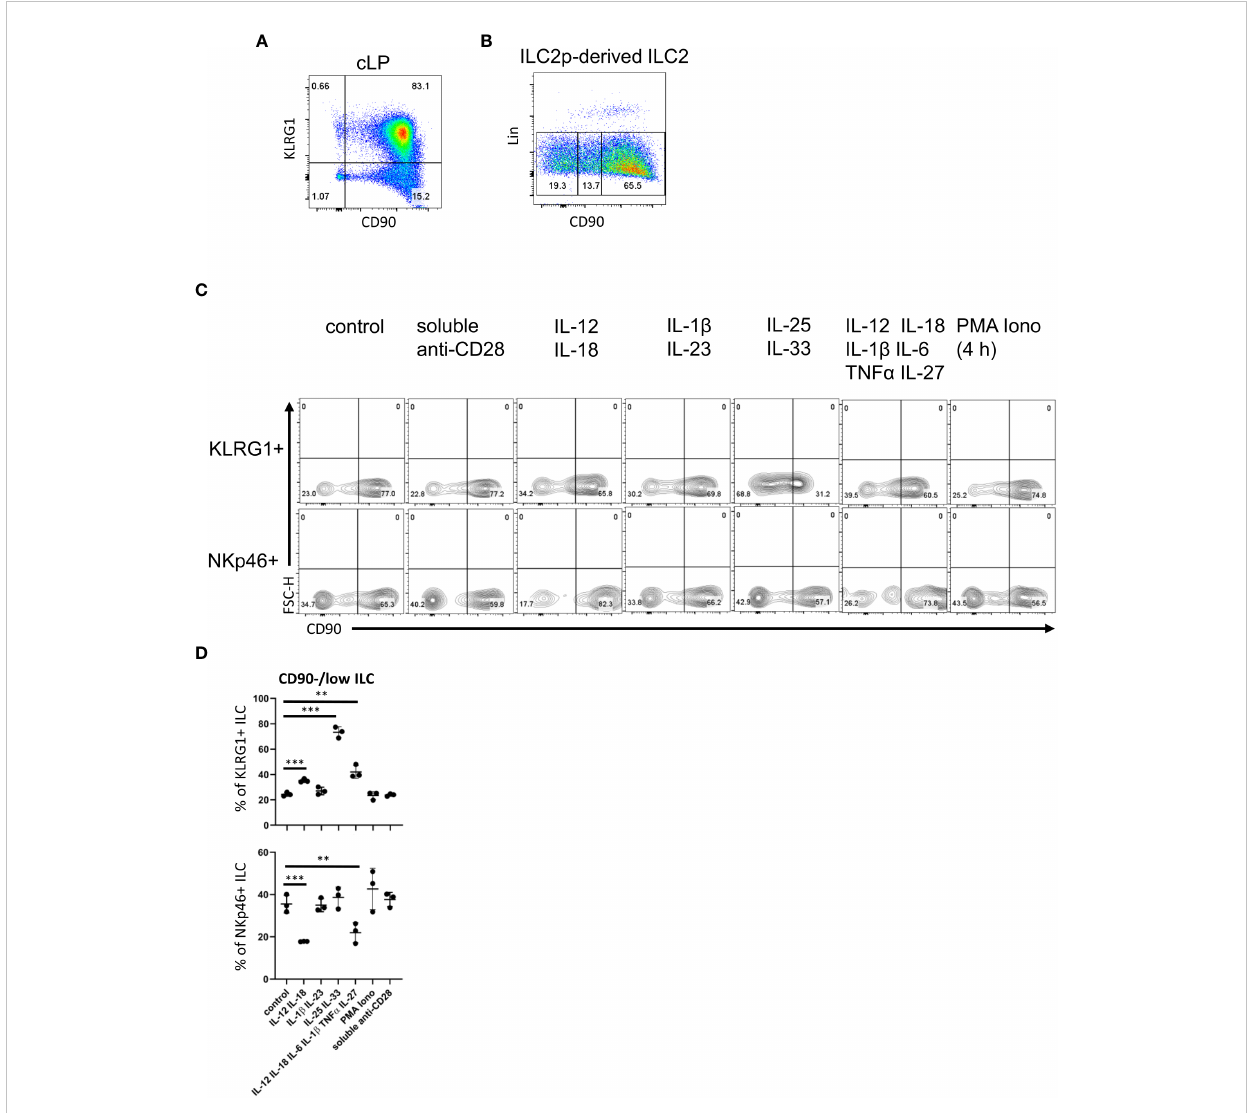
FIGURE 2 cLP ILC have a variable expression of CD90 depending on stimulatory cues. (A) KLRG1 and CD90 co-expression in cLP CD127 + ILC was demonstrated by fl ow cytometry (n=12). (B) ILC2 were generated from ILC2p stimulated with IL-7, SCF and IL-33, and seeded onto OP9-DL1. CD90 hi , CD90 low and CD90 - ILC2 are shown. (C, D) KLRG1 + or KLRG1 - CD127 + ILC were isolated and stimulated in vitro for 48 hours prior to harvest and fl ow cytometry analyses of KLRG1 + or NKp46 + ILC, respectively. In addition to a control condition, soluble agonistic anti-CD28 antibodies, IL-12&IL-18, IL-1 b &IL23, IL-25&IL-33 or IL-12&IL-18& IL-1 b &IL-6&TNF a &IL-27 were used as stimuli. In a separate condition designated as “ PMA Iono ” , sorted cells were stimulated with PMA and ionomycin in the presence of monensin for the fi nal 4 hours prior to harvesting. (D) Flow cytometry analyses of CD90 hi and CD90 low/neg CD127 + ILC and statistical analyses of CD90 low/neg ILC frequencies among KLRG1 + or NKp46 + cLP ILC are outlined. Data shown are representative of 3 biological replicates. **p< 0.01;